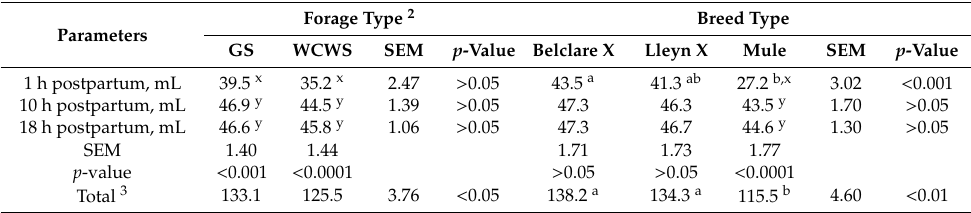
Table 6. The e ff ect of forage type and breed type on lamb colostrum intake per kg of birth weight 1 (least square means ± SEM).